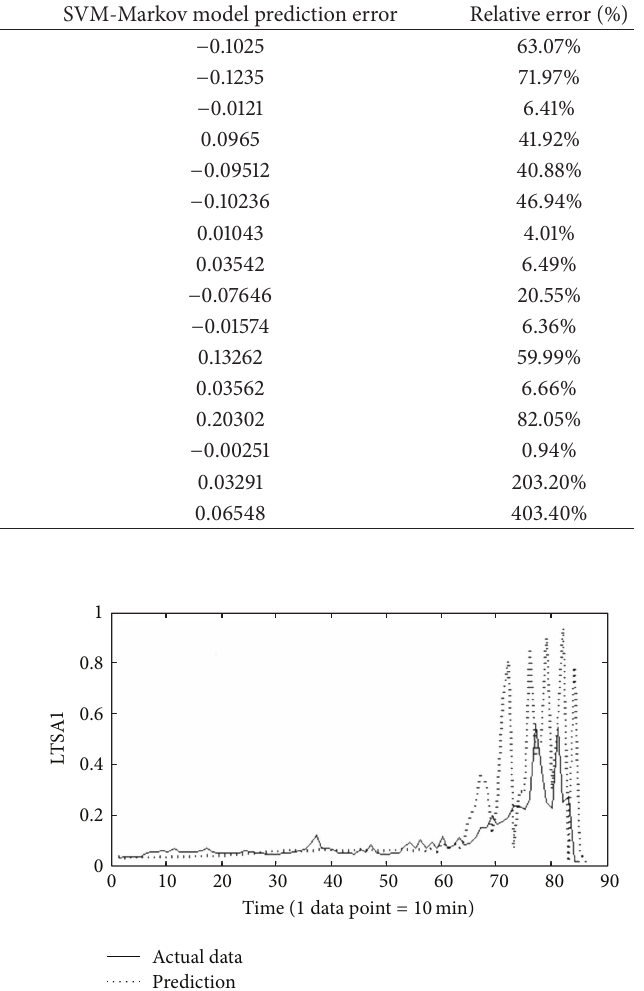
Table 4: The corrected results of the points 70–85 based on Markov model.